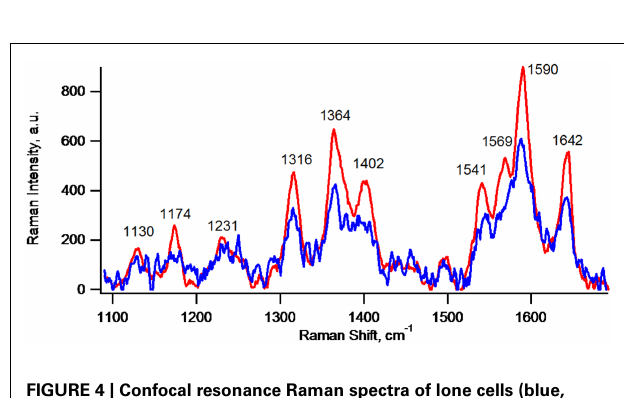
FIGURE 4 | Confocal resonance Raman spectra of lone cells (blue, average of spectra of seven lone cells) and of clustered cells (red, average of spectra of seven different regions of a cell cluster) of the same G. sulfurreducens lag phase biofilm depicted in Figures 1–3 .